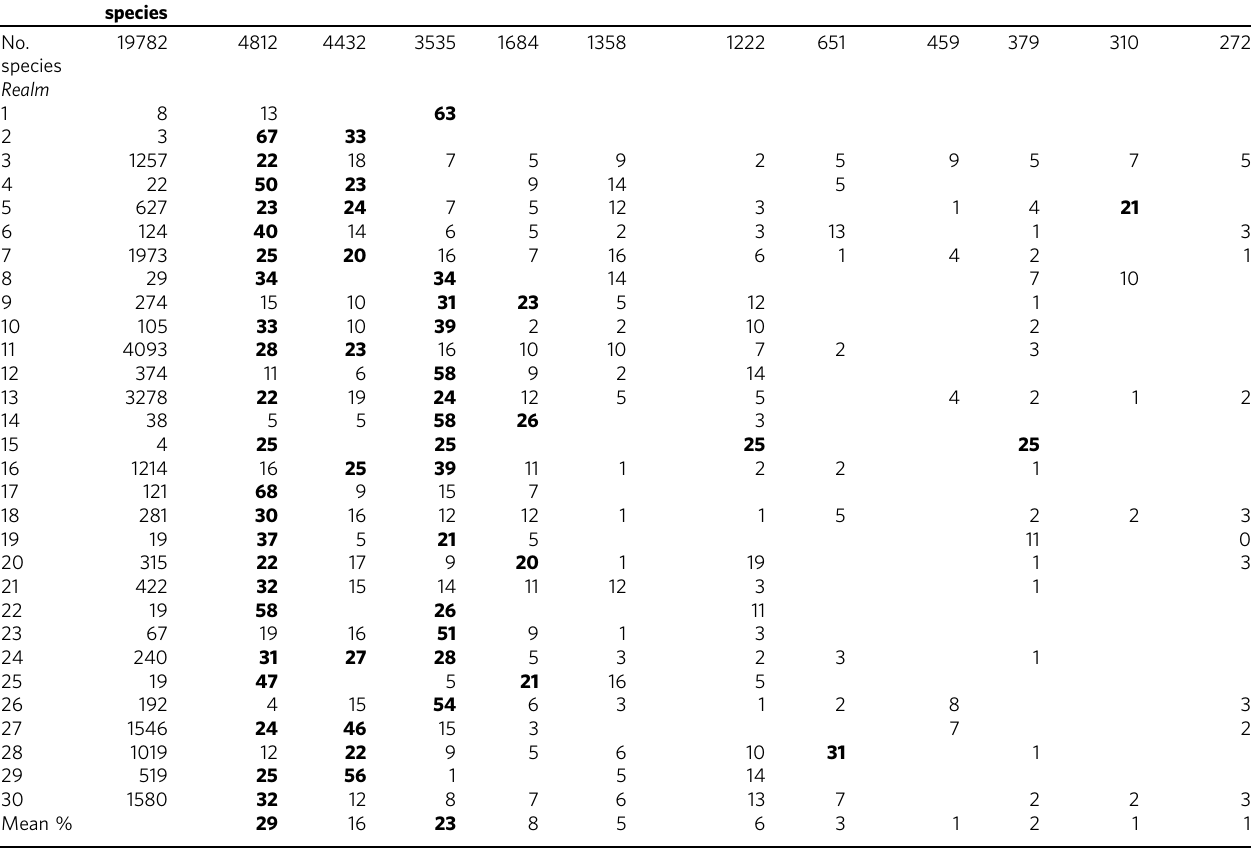
Table 1 The percentage of ‘ endemic ’ species in the most species-rich phyla that occurred in more than one 5 o cell and only one realm Phylum No.